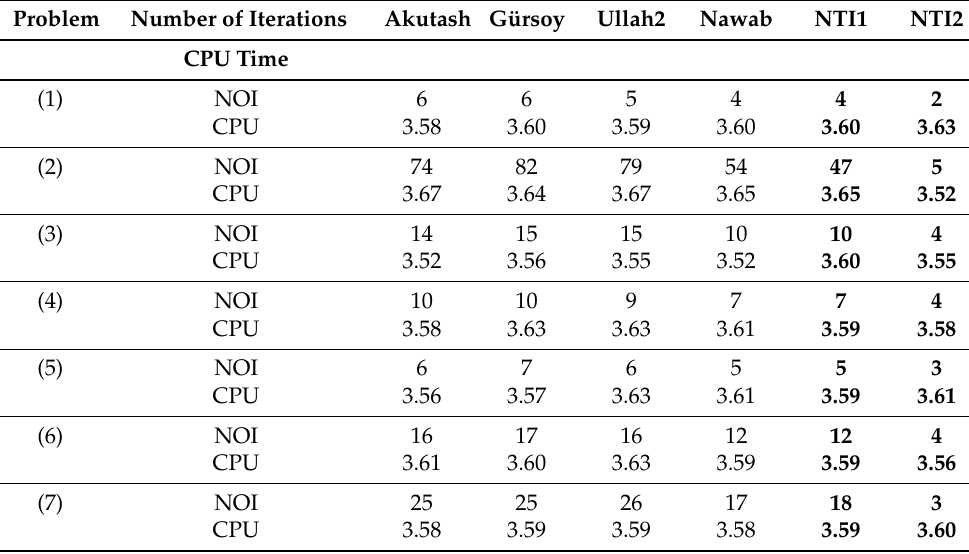
Table 6. Results of comparison of three-step methods on problems in Table